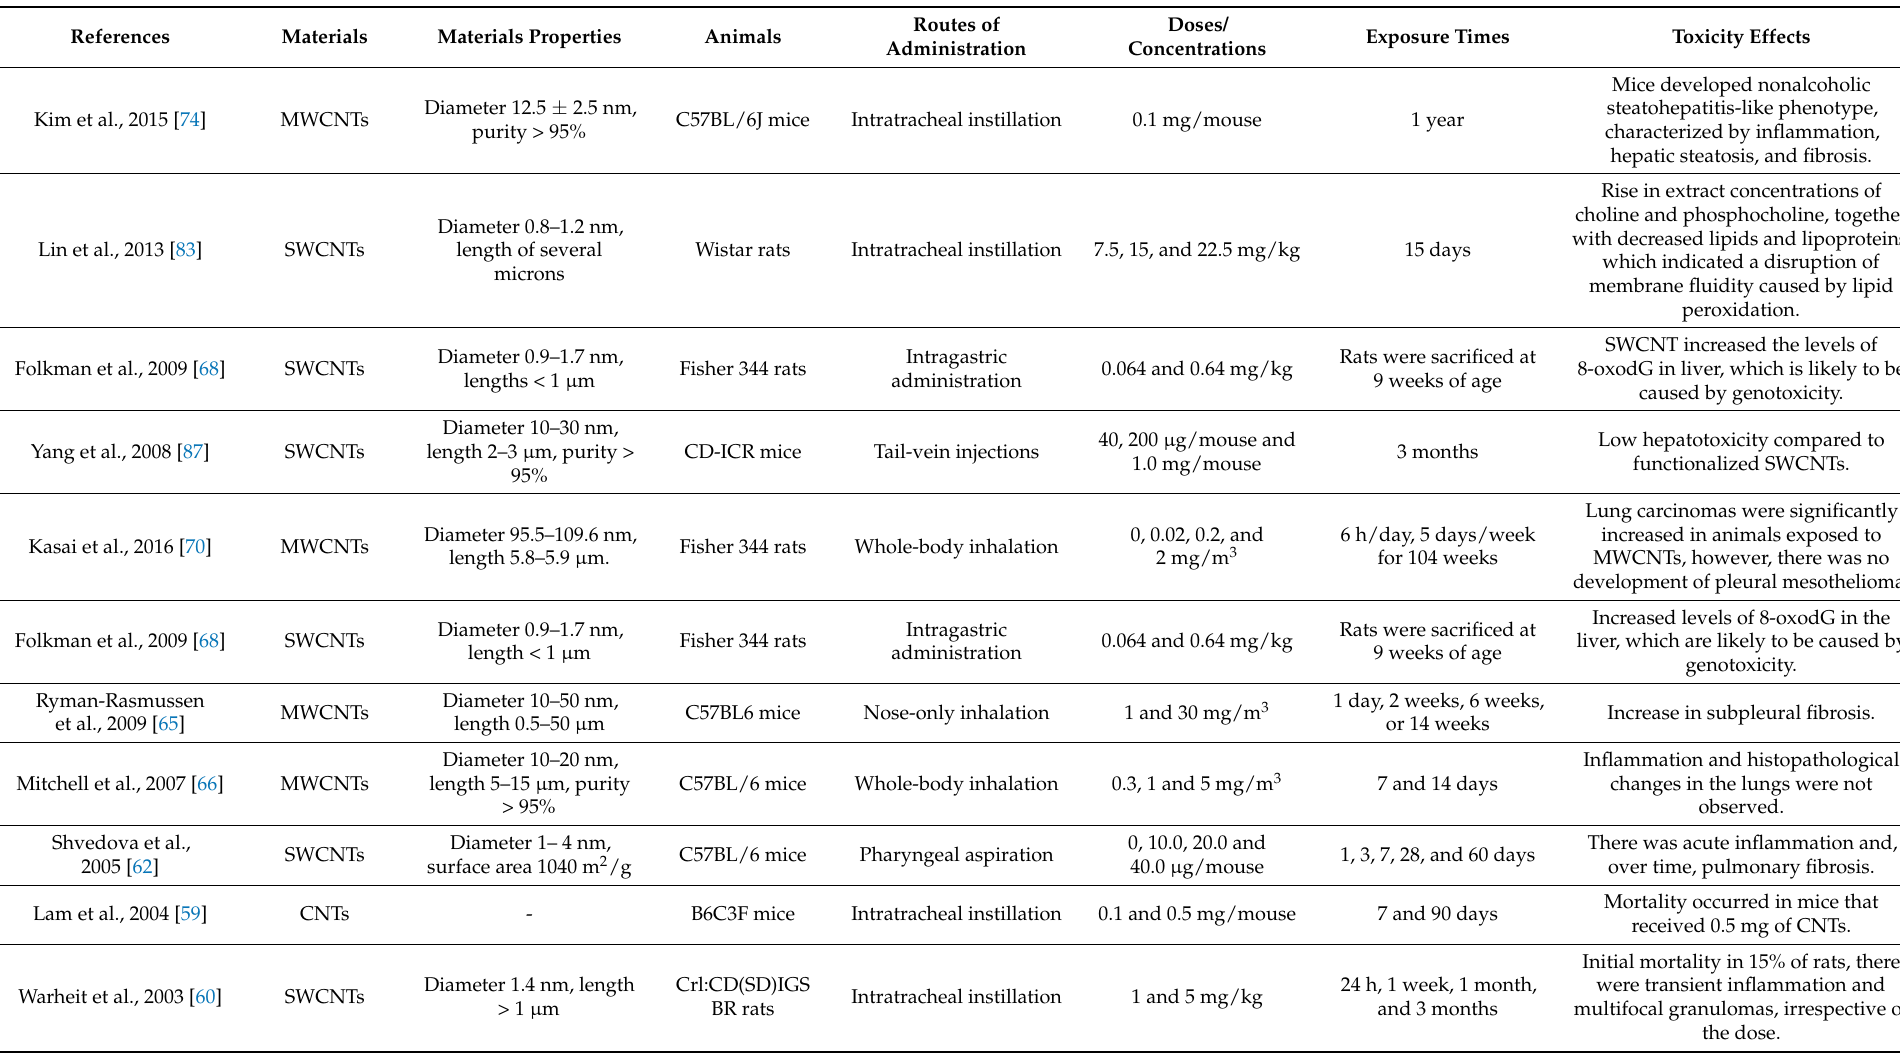
Table 2. Hepatotoxicity of pristine carbon nanotubes using rodents as animal